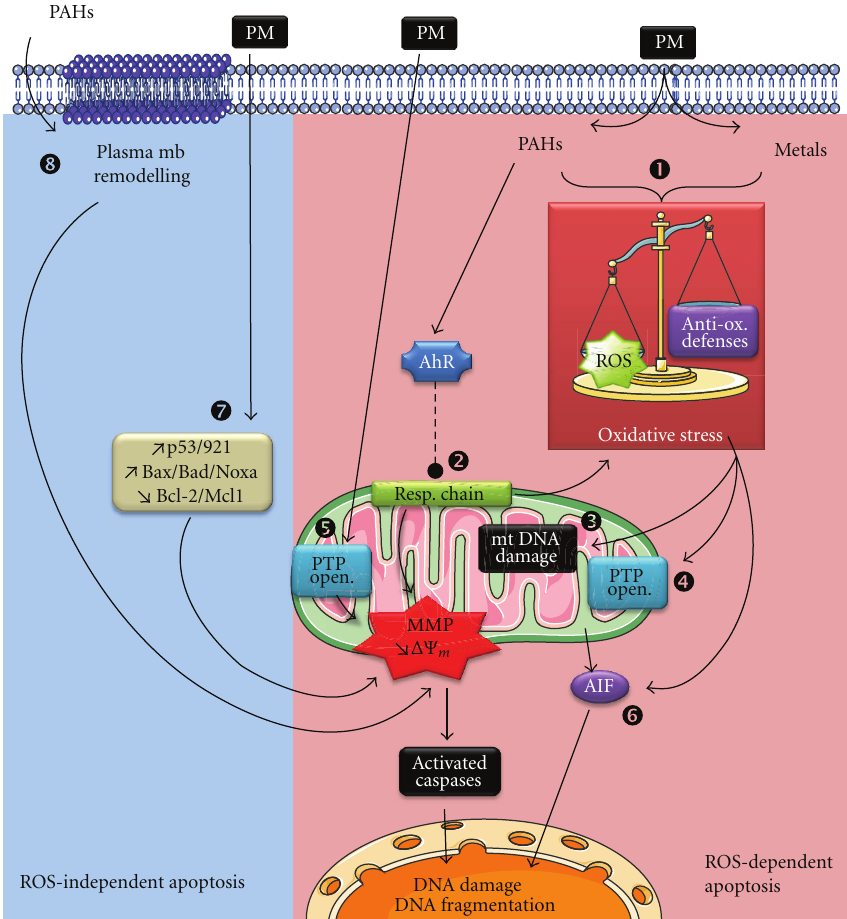
Figure 1: ROS-dependent and -independent apoptosis induced by particulate pollutants. Particulate matter (PM) or their compounds (PAHs and metals) provoke apoptotic cell death through ROS-dependent (pink zone) or ROS-independent (blue zone) pathways. Actually, particulate pollutants are considered as potent ROS generators from organic (i.e., PAHs) or metallic compounds (1) and leading to oxidative stress as the result of the unbalance between ROS production and activation of antioxidant defenses. Senft et al. demonstrated that AhR activation might regulate the mitochondrial respiratory chain function and induce production of O 2 •− and H 2 O 2 from mitochondria ([83], (2)). As a consequence of oxidative stress, mitochondria are harmed by ROS that are responsible for damage of mitochondrial DNA (3), mitochondrial lipid peroxidation, and opening of PTP complex (PTP open. (4)). Mitochondrial membrane permeabilization (MMP) and PTP opening might also be a direct e ff ect of diesel particles on isolated mitochondria ([84], (5)). As an additional pathway of the ROS- dependant apoptosis induced by air pollutants, the apoptogenic activity of AIF might be enhanced by xenobiotics, air pollutants, or their ROS derivatives (6). Some other ROS-independent signaling pathways have been identified such as the upregulation of proapoptotic proteins and/or the repression of prosurvival Bcl-2 family proteins (7). Recent publications also demonstrated a new mechanism of apoptosis triggered by PAHs through alterations of lipid rafts’ composition and remodeling of the plasma membrane (8). Illustrations carried out thanks to Servier Medical